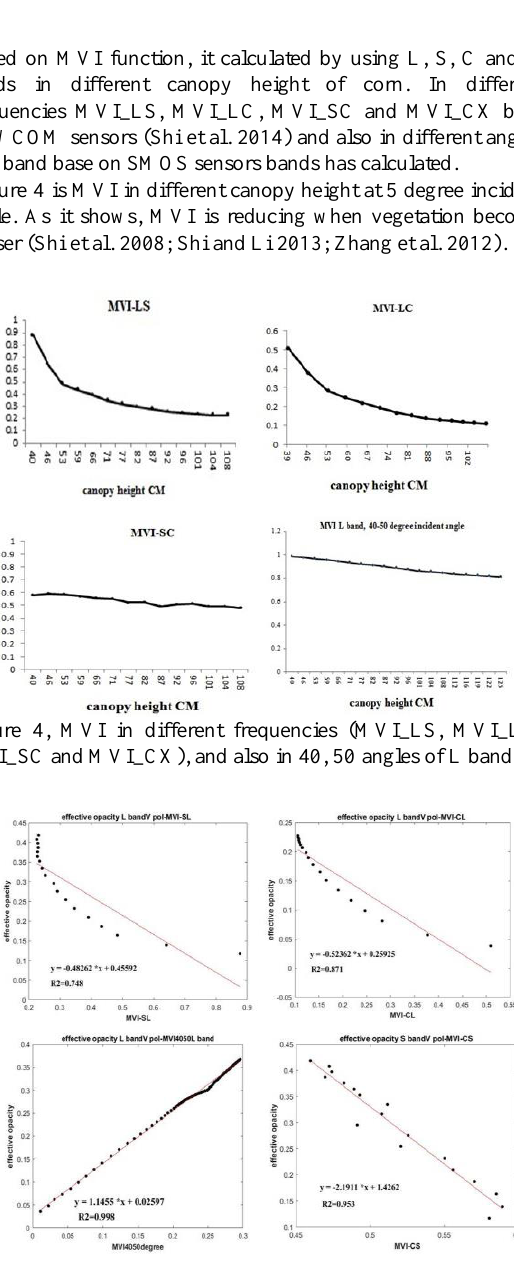
Figure5, Comparing MVI in different frequencies (MVI_LS, MVI_LC, MVI_SC and MVI_CX), and also in 40, 50 angles of L band with effective optical